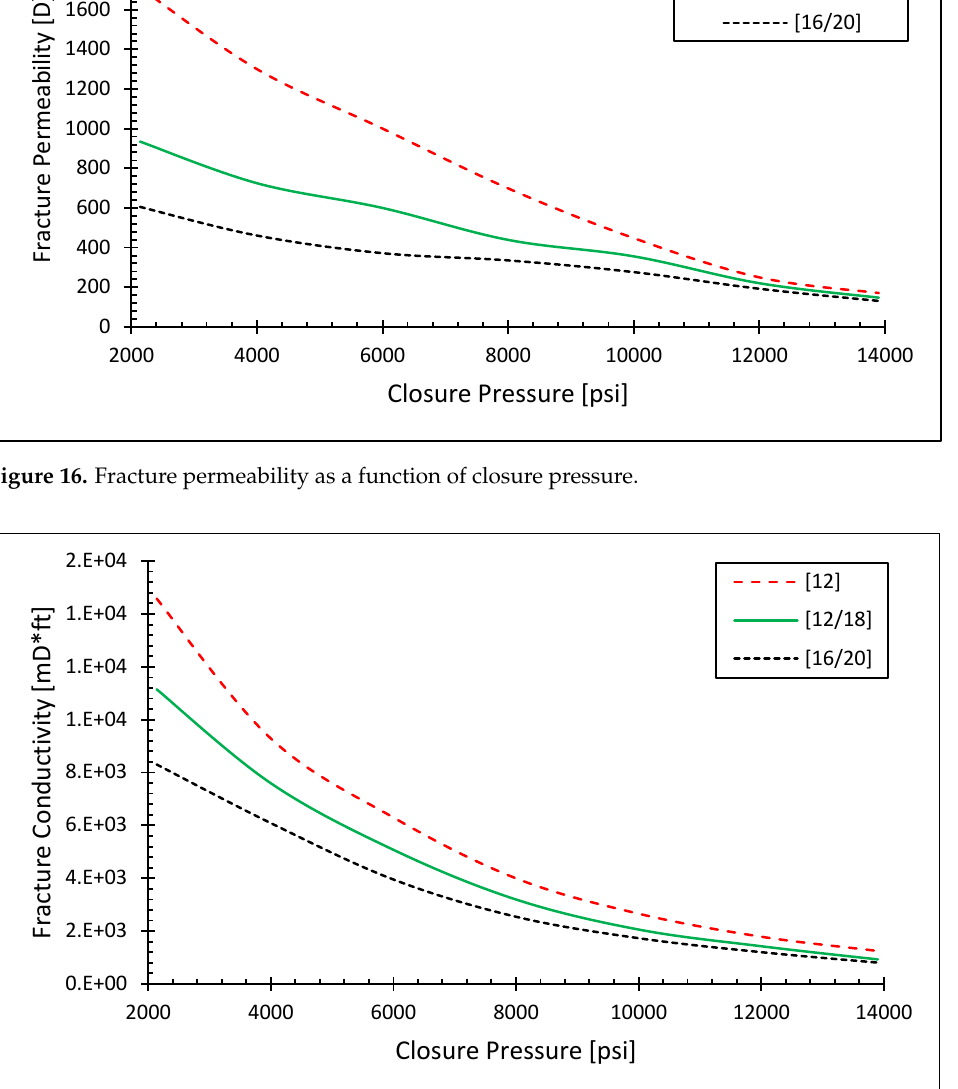
Figure 18. Fracture conductivity for different formation Young ’ s modulus. 4. Discussion